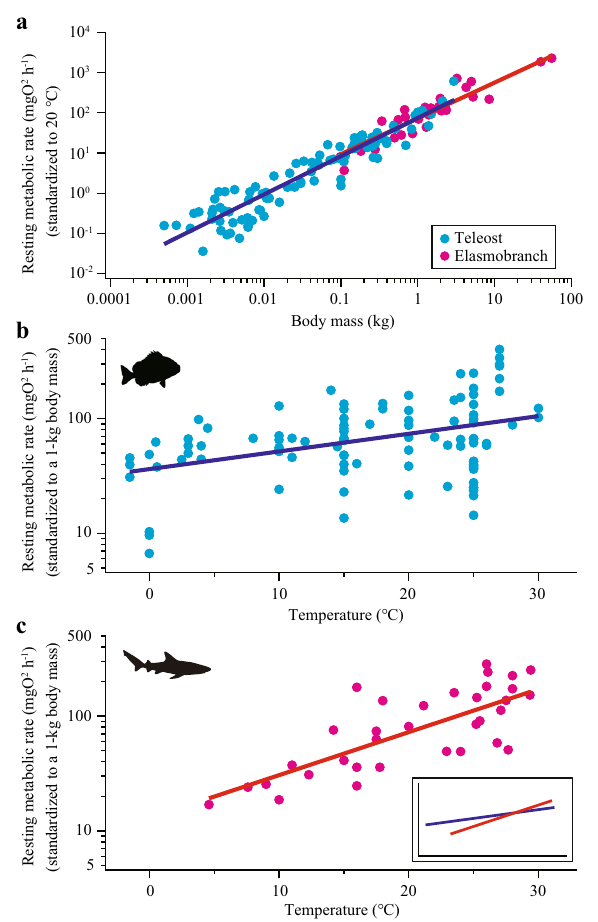
Fig. 2 | Interspeci fi c allometry and temperature dependence of resting meta- bolic rates (RMRs) in teleosts (light blue) and elasmobranchs (pink). a AllometricrelationshipsofRMRsstandardizedto20°Cusingtheinterspeci fi cQ 10 (1.43 for teleosts and 2.37 for elasmobranchs) estimated with the phylogenetic generalizedleastsquares(PGLS)method.ThicklinesaretheestimatesofRMRsfor a temperature of 20°C based on PGLS [teleost, log 10 (RMR)=0.95*log 10 (mass) + 1.87; elasmobranch, log 10 (RMR)=0.89*log 10 (mass) + 1.86]. b , c Temperature dependance of RMRs standardized to a 1-kg body mass using the allometric slope (0.95forteleostsand0.89forelasmobranchs)estimatedwithPGLS.Thicklinesare the estimates of RMRs for a 1-kg body mass based on PGLS [teleost, log 10 (RMR)=0.0154*temp + 1.56; elasmobranch, log 10 (RMR)=0.0375*temp + 1.11]. c Inset shows a comparison between teleosts and elasmobranchs. Source data are provided as a Source Data fi